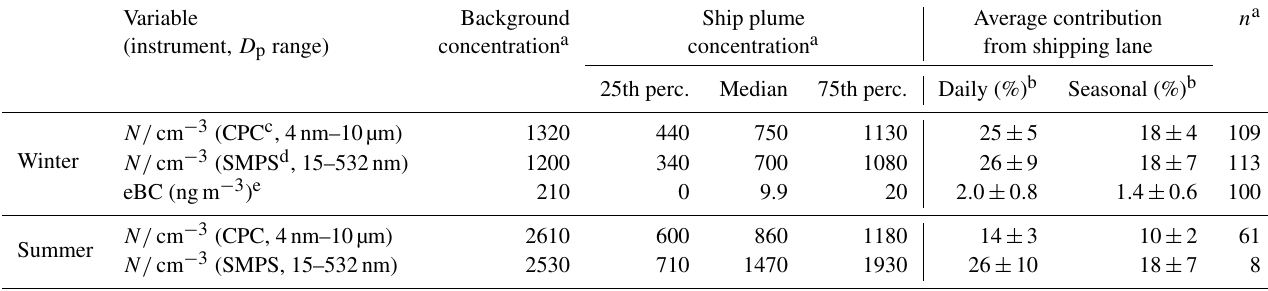
Table 3. Contribution of particle number concentration and eBC mass concentration to local air quality, from two measurement campaigns at the Falsterbo coastal